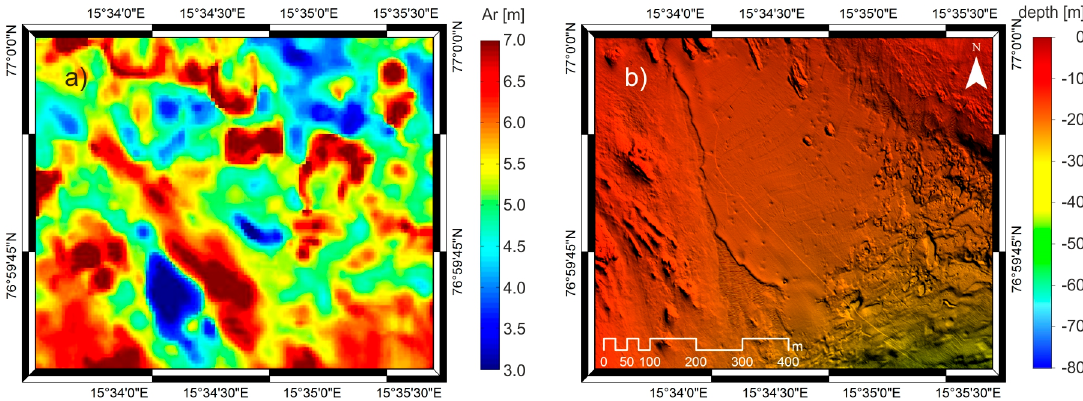
Figure 11. Detailed maps of the bottom of Isbjørnhamna and Hansbukta Bays in Hornsund Fjord, which compare the autocorrelation length (a parameter describing the terrain roughness with a spatial scale in the range of 1–49 m, for DEM with a step of d = 0.5 m in the moving window with a side length of 70 m and 90% overlapping) and the bathymetry of the area; ( a ) value of the autocorrelation length and ( b ) seafloor morphology in the place with mass-movement landforms and megaripples.